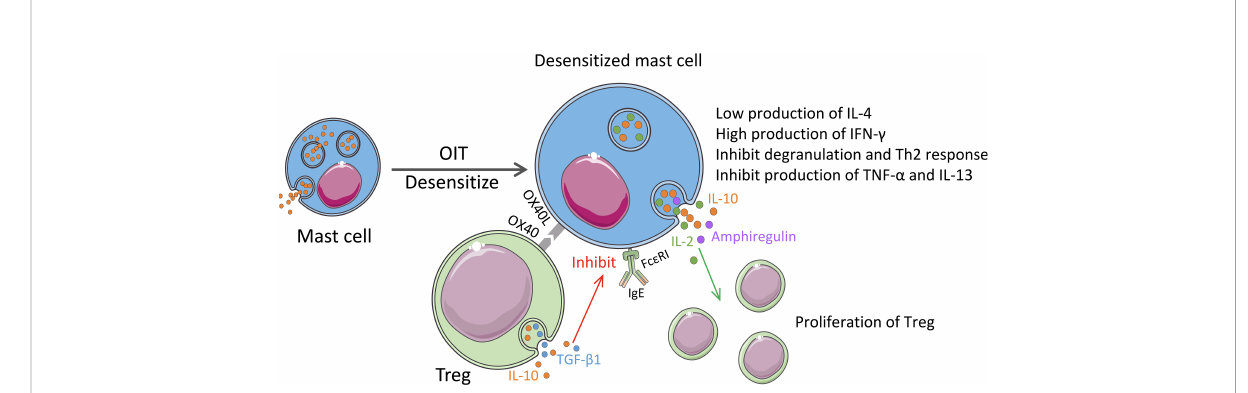
FIGURE 3 Regulatory properties of MCs in the immunotherapy. OIT treatment for food allergy induces desensitization of MCs with the low expression of Th2 cytokines and induces expression of IFN- g . Desensitized MCs also synthesize IL-2 and IL-10. MC-derived IL-2 and amphiregulin promote proliferation and enhancement of the function of Tregs. Activated Tregs release IL-10 and TGF- b 1, and the OX40 on their surface binds to OX40L from MCs, which inhibits the expression of Fc ϵ RI on MCs and the release of TNF- a and IL-13, thereby inhibiting the Th2